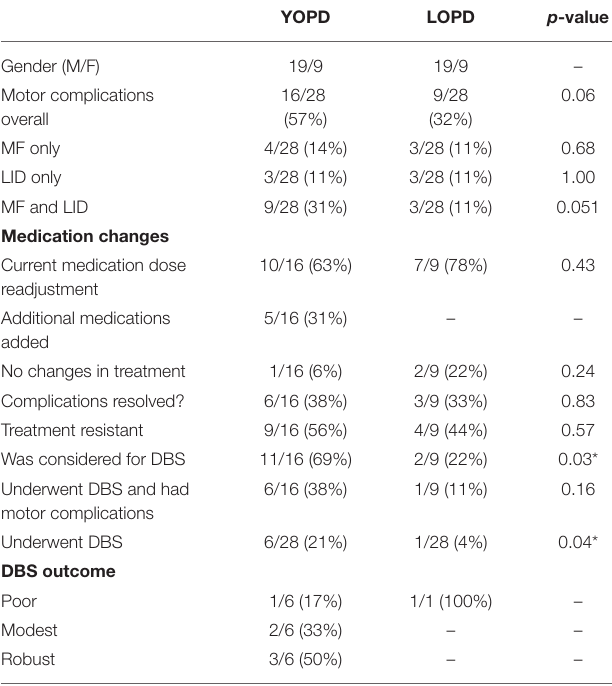
TABLE 2 | Motor complications and treatment outcome in YOPD and